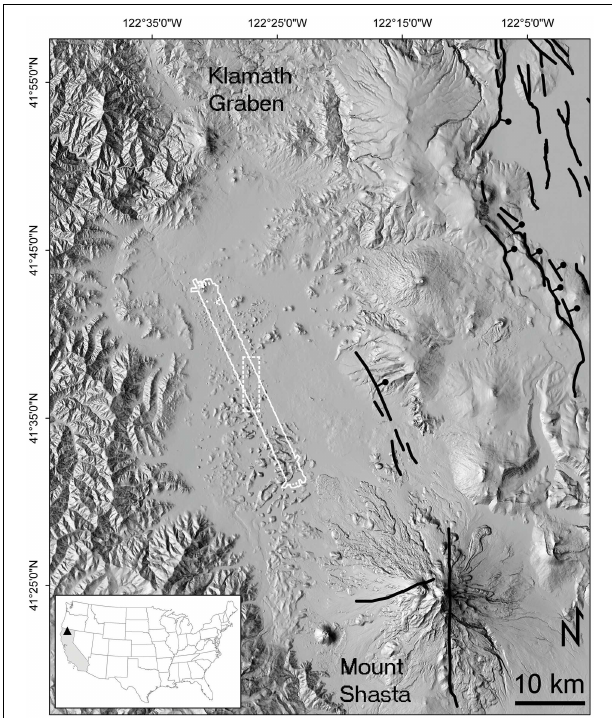
FIGURE 2 | Map of the fault system in the Shasta valley area, showing previously mapped faults ( Jennings and Bryant, 2010) as thick black lines. Downthrown side (relative or apparent) indicated on faults, if known. The airborne LiDAR strip is outlined in solid white and the location of the zoom in Figure 3 is outlined in dashed white. In the inset, location of Mt Shasta (triangle) in Northern California.